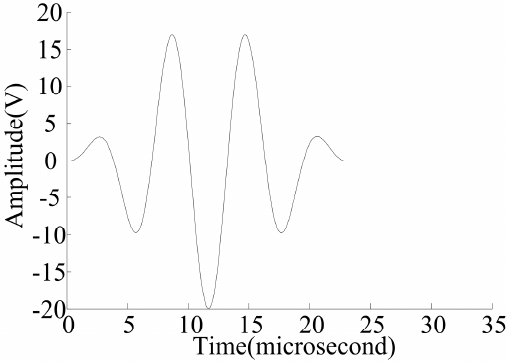
Figure 3. An excitation signal with 0.16 MHz.